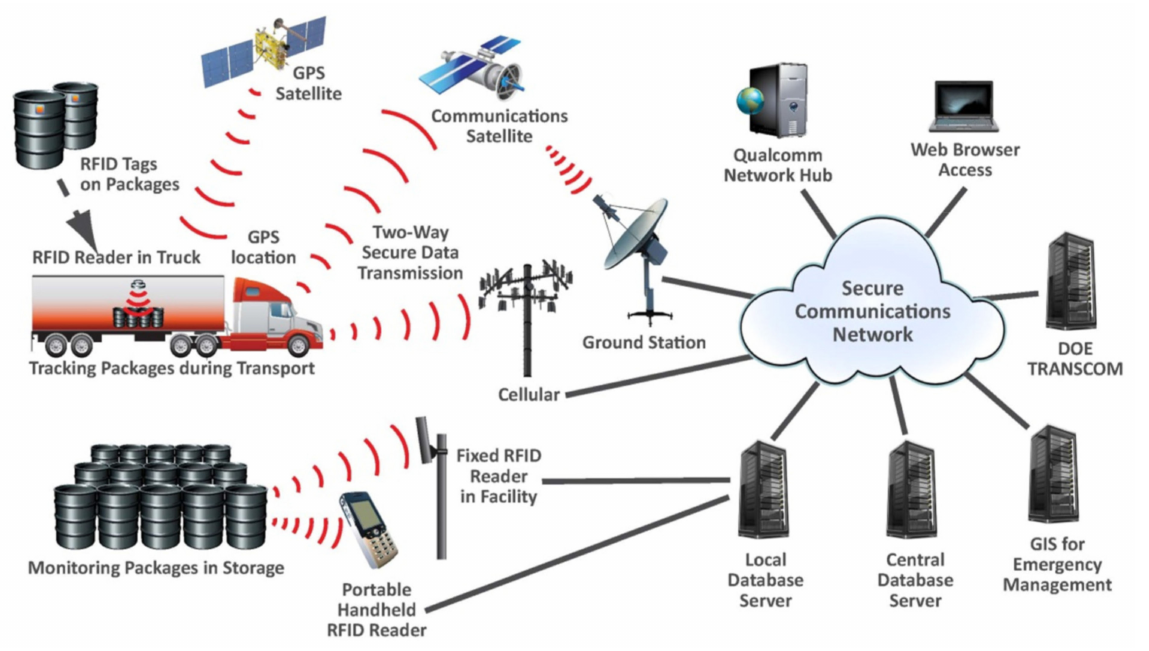
Figure 3. RFID scheme in the oil logistics company